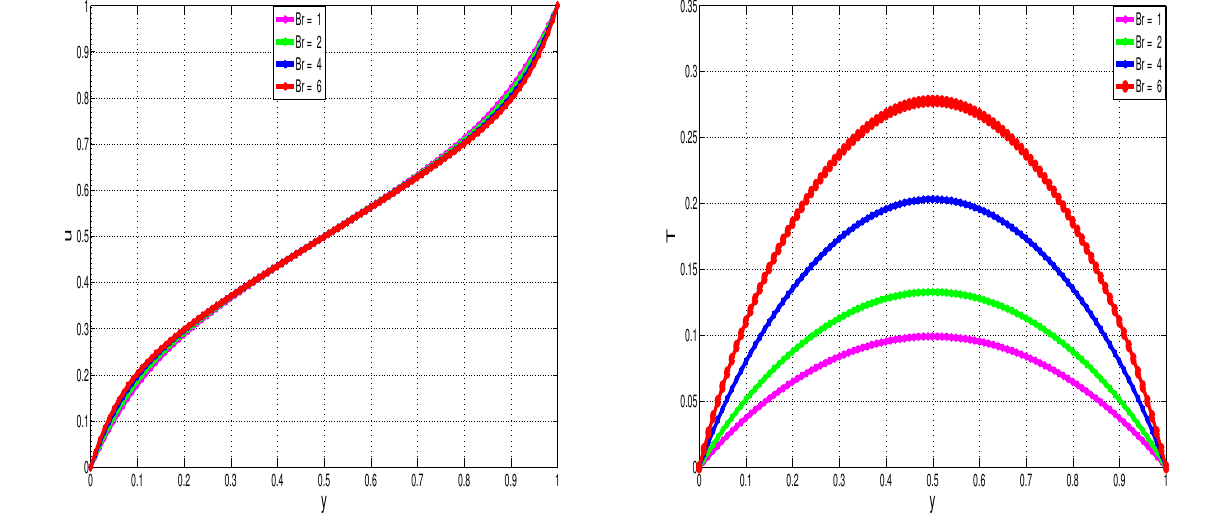
Figure 16. Sensitivity of VFBN velocity ( left ) and temperature ( right ) to variations in Br.